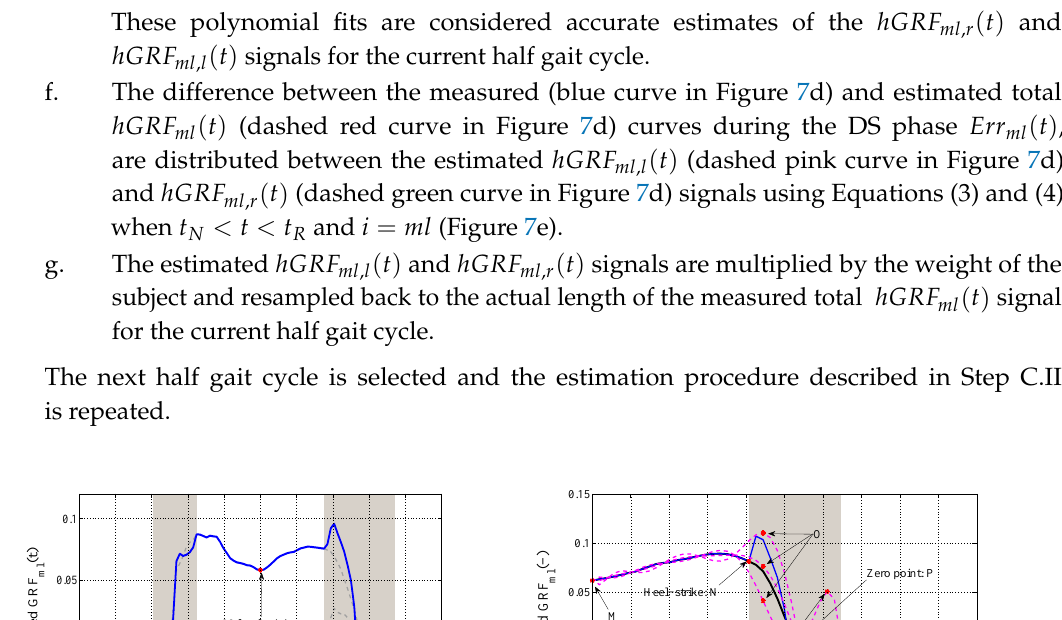
(Figure 7c) (cid:1872) (cid:3016)(cid:4593) = (cid:1872) (cid:3019)(cid:4593) − 0.05(cid:1846) , (cid:1872) (cid:3018)(cid:4593) = ((cid:1872) (cid:3015)(cid:4593) + (cid:1872) (cid:3017)(cid:4593) )/2 ,